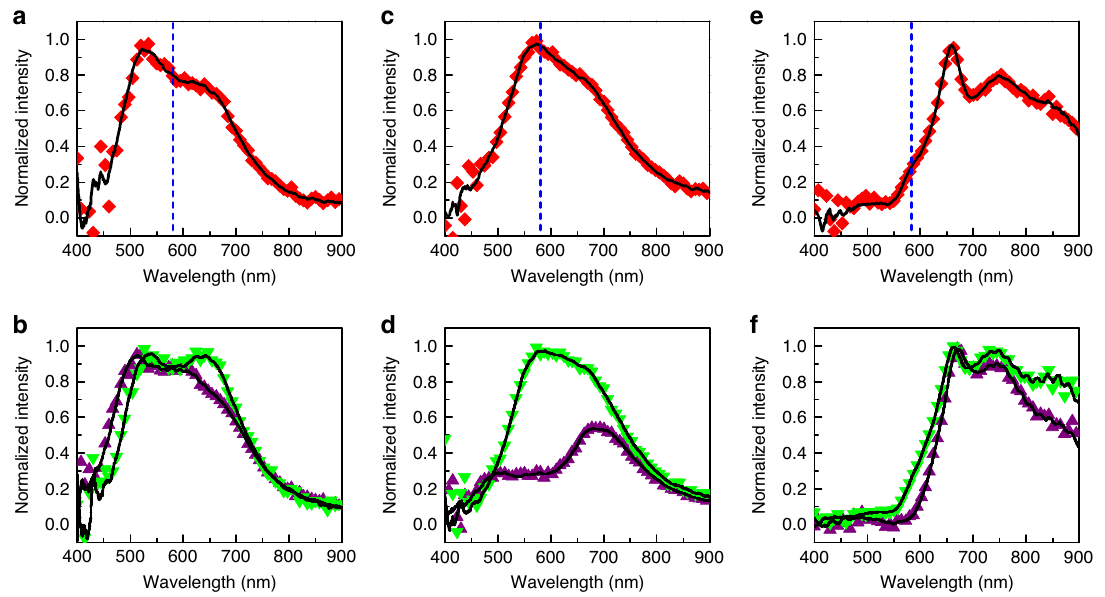
Fig. 4 Tuning of the all-dielectric meta-atom. a – f Scattering spectra of two single a-Si:H NPs(40) (diameter: ~300 and ~325 nm, respectively) ( a – d ) and a single a-Si:H NP(20) (diameter: ~280 nm) ( e , f ) covered by PMMA + SP layer. a , c , e Right after the sample preparation. b , d , f After the exposure to UV light (purple triangle) and after the exposure to the green light (green triangle). The vertical dashed blue dashed line illustrates the absorption peak of MC molecules. The black curves are smoothed spectral